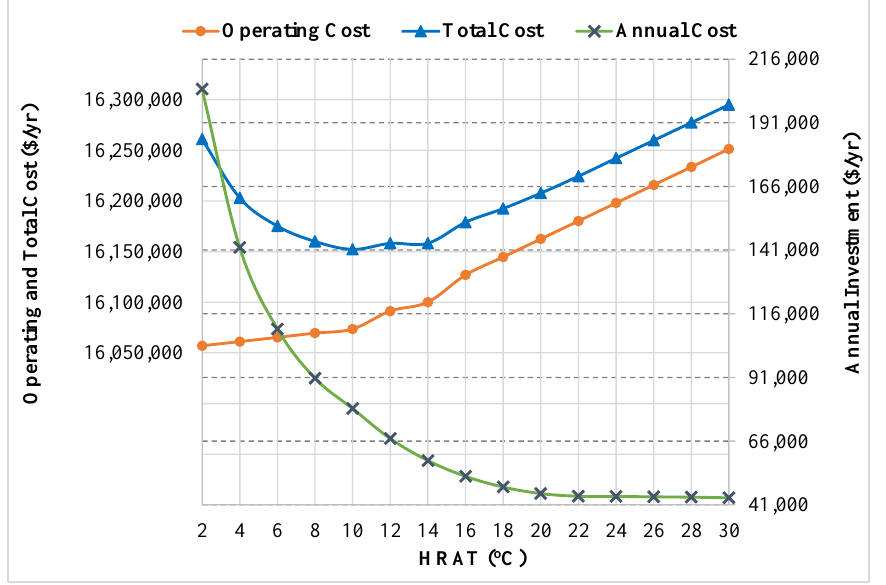
Figure 6. Economic profile of the optimized HEN using option (3).